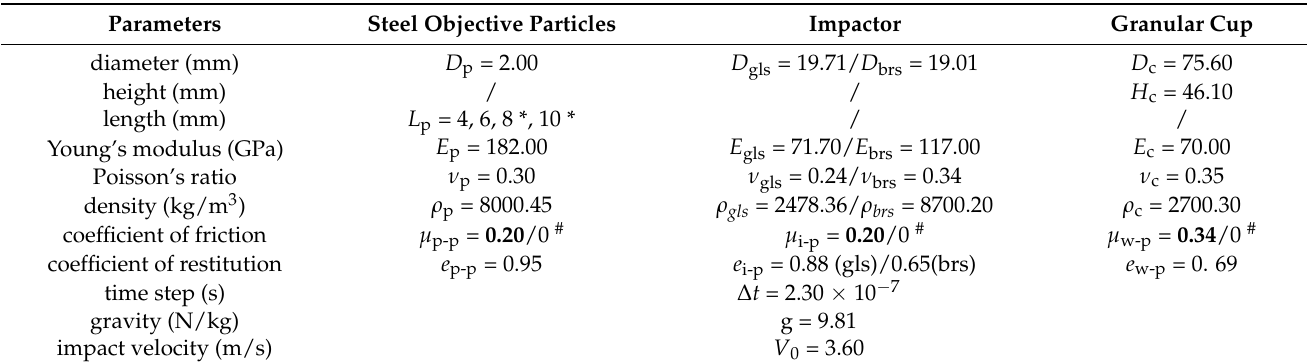
Figure 1. Schematic drawing of the experimental apparatus. (The arrow represents the velocity direction of the impactor.) direction of the impactor.) Table 2. Parameters used in the experiments and DEM